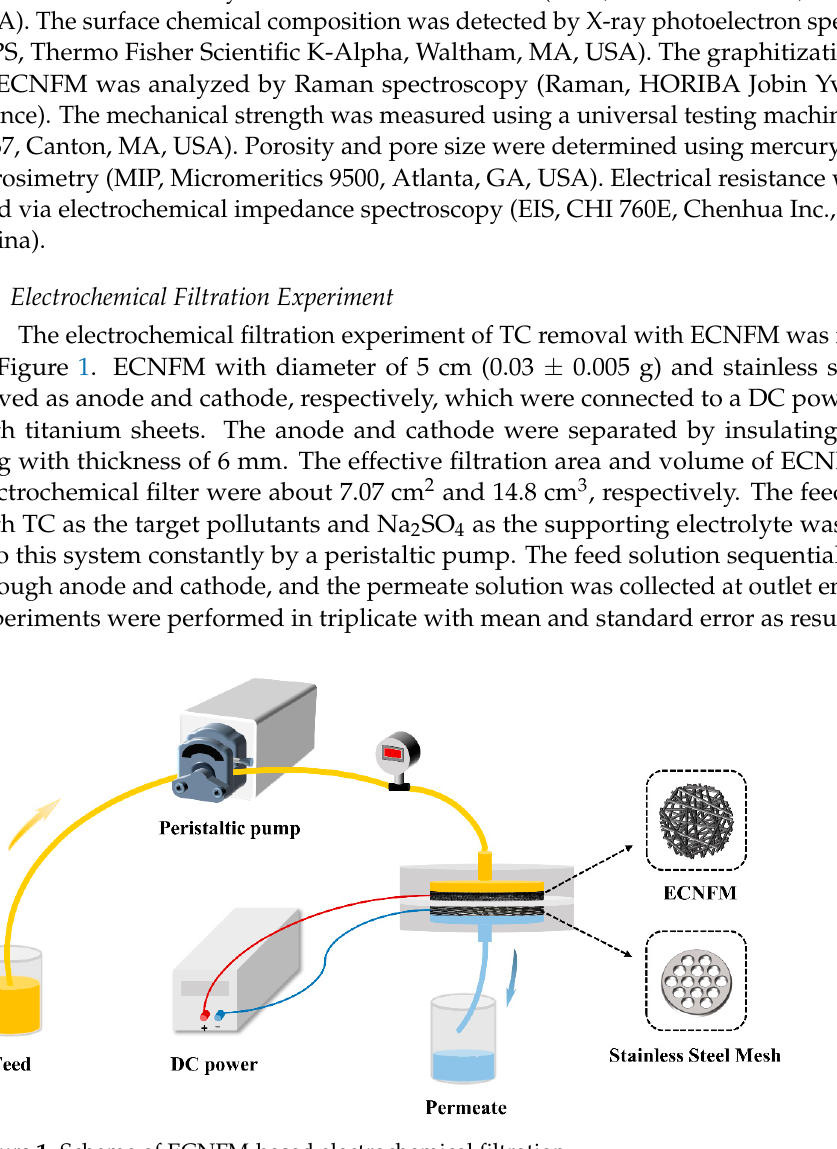
Figure 1. Scheme of ECNFM-based electrochemical filtration.